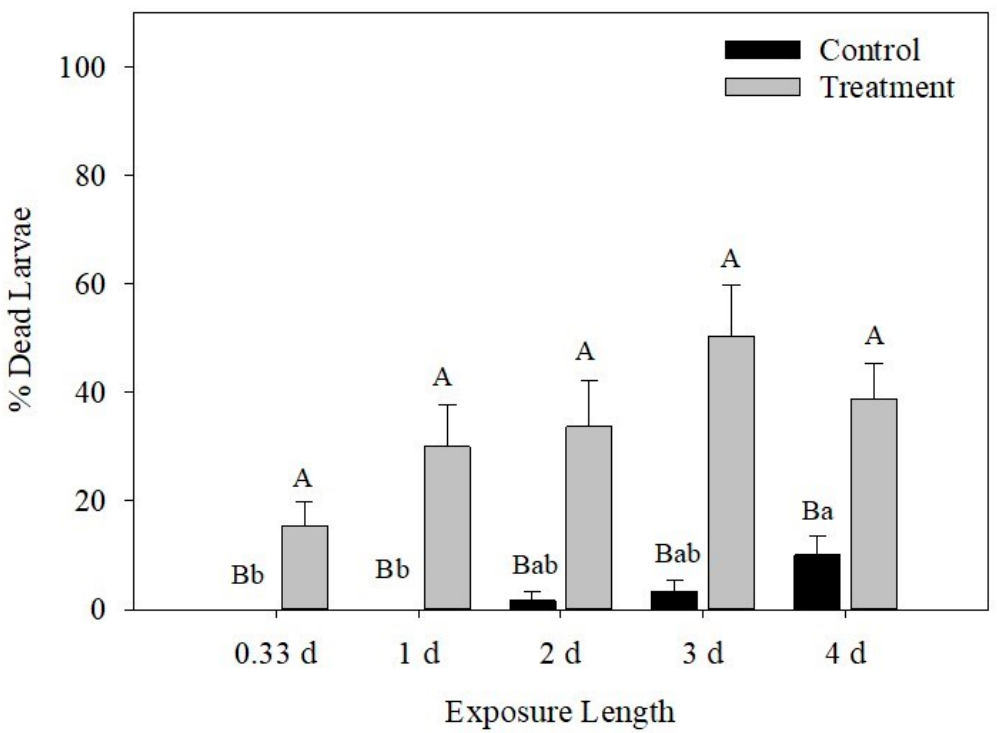
Figure3. Percent(mean ± SE)deadlarvaeafterexposuretodeltamethrin-treated(graybars)oruntreated Figure 3. Percent (mean ± SE) dead larvae after exposure to deltamethrin-treated (gray bars) or (black bars) packaging material for 0.33–4 days. Di ff erent uppercase letters among control and treatment untreated (black bars) packaging material for 0.33–4 days. Different uppercase letters among control means are significantly di ff erent at each exposure length ( p < 0.05; by Ryan–Einot–Gabriel–Welsch and treatment means are significantly different at each exposure length ( p < 0.05; by Ryan–Einot– (REGWQ) multiple range test). Di ff erent lowercase letters among all exposure lengths are significantly Gabriel–Welsch (REGWQ) multiple range test). Different lowercase letters among all exposure di ff erent among control packaging ( p < 0.05; by lengths are significantly different among control packaging ( p < 0.05; by RGEWQ).